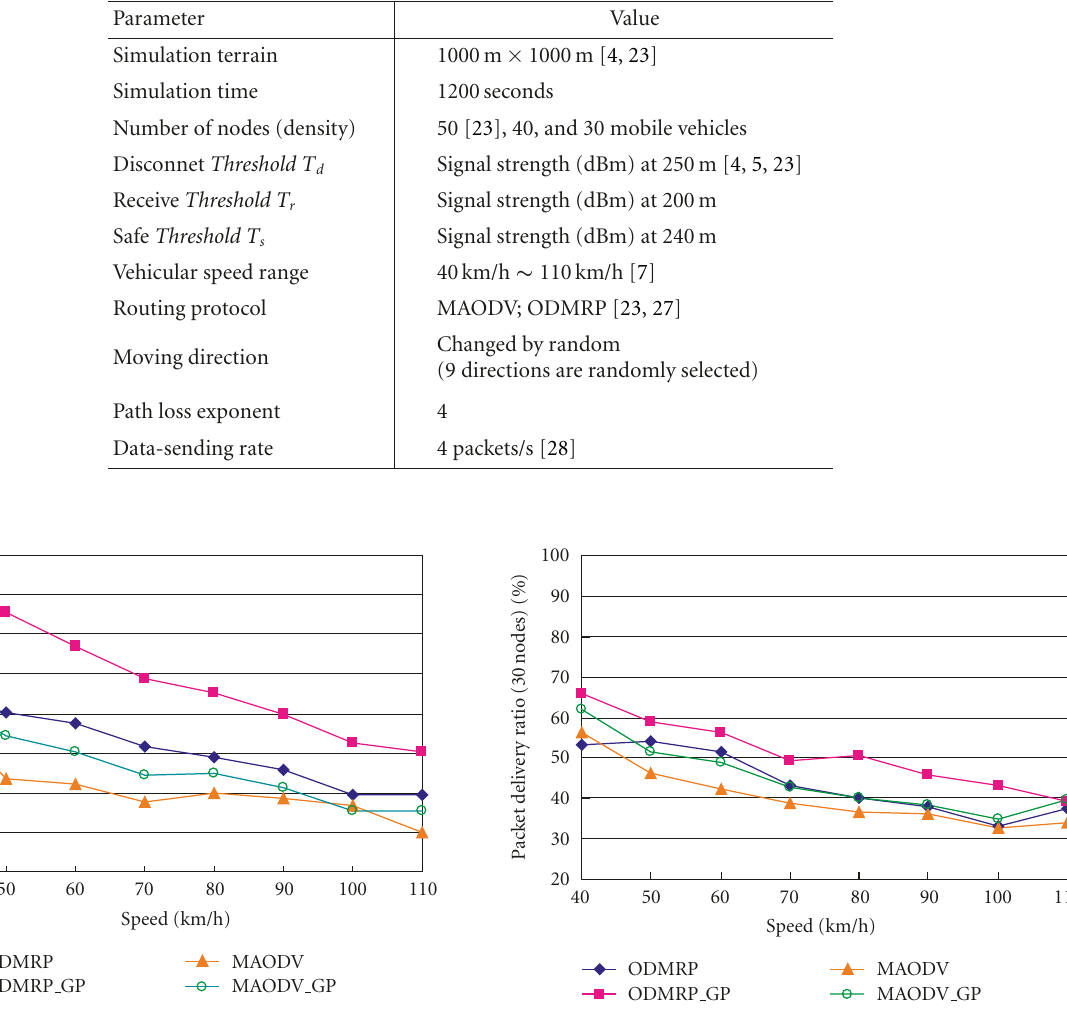
Figure 13: Packet delivery ratio versus mobility speed (30